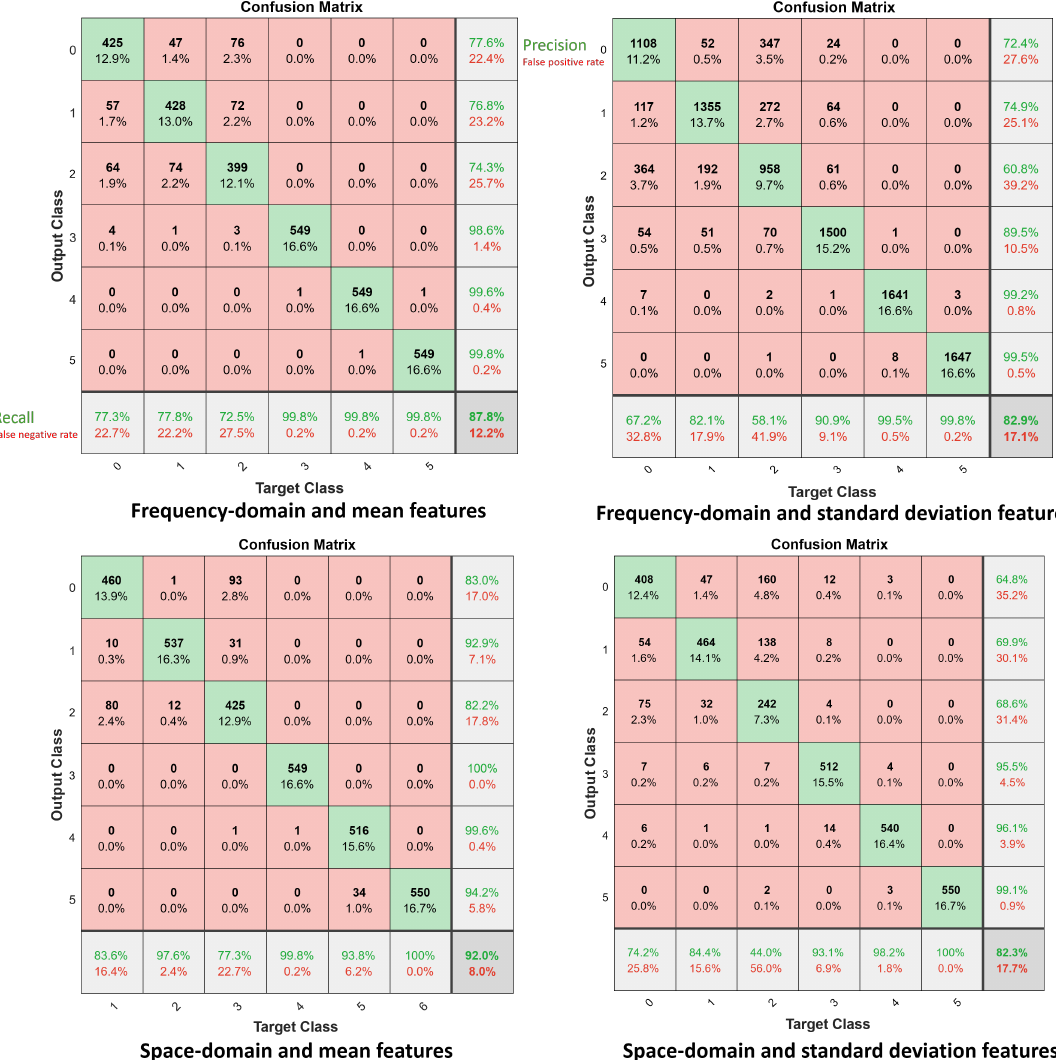
Figure 9. Confusion matrices for the FF-NN classifier for subject counting, C = 0,1,2,...,5 where C = 0 corresponds to the empty environment. Top figure: frequency domain CSI features: mean ( left ) and standard deviation ( right ). Bottom figure: space domain CSI features: mean ( left ) and standard deviation ( right